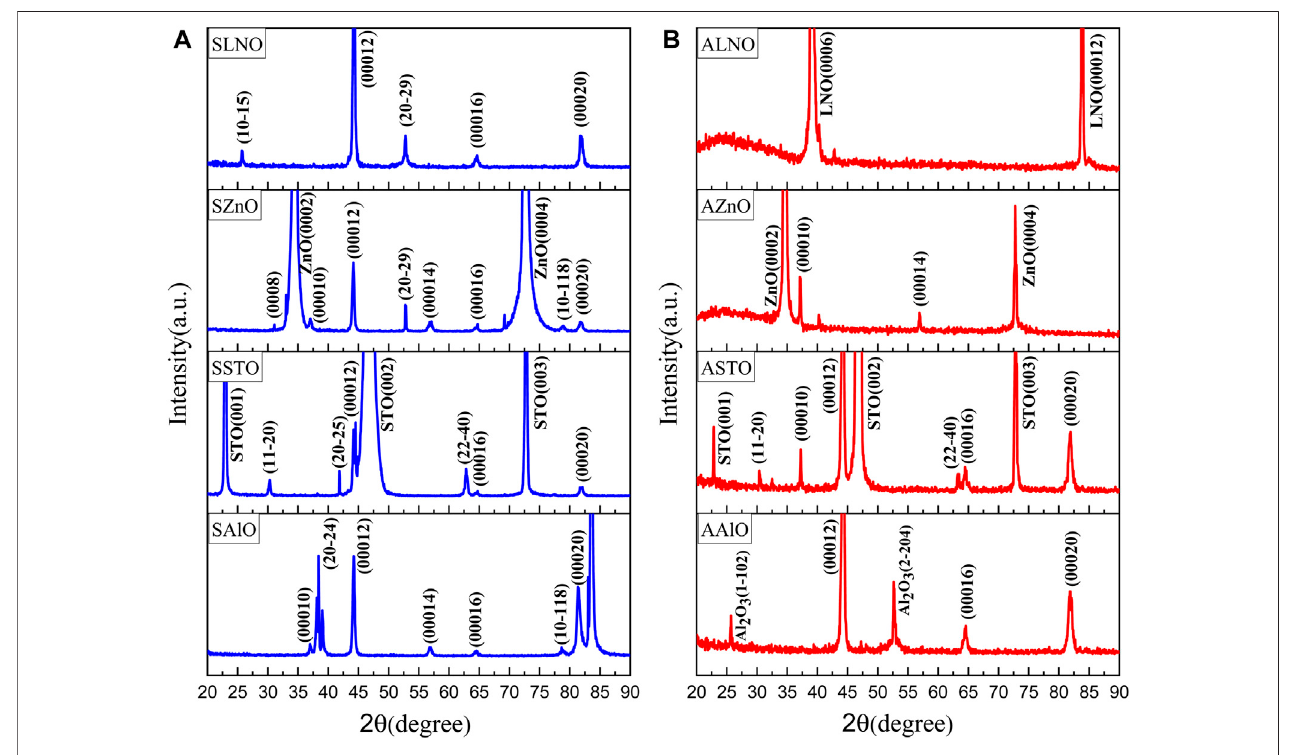
FIGURE 2 | (A) XRD patterns of fi lms on different substrates (B) after